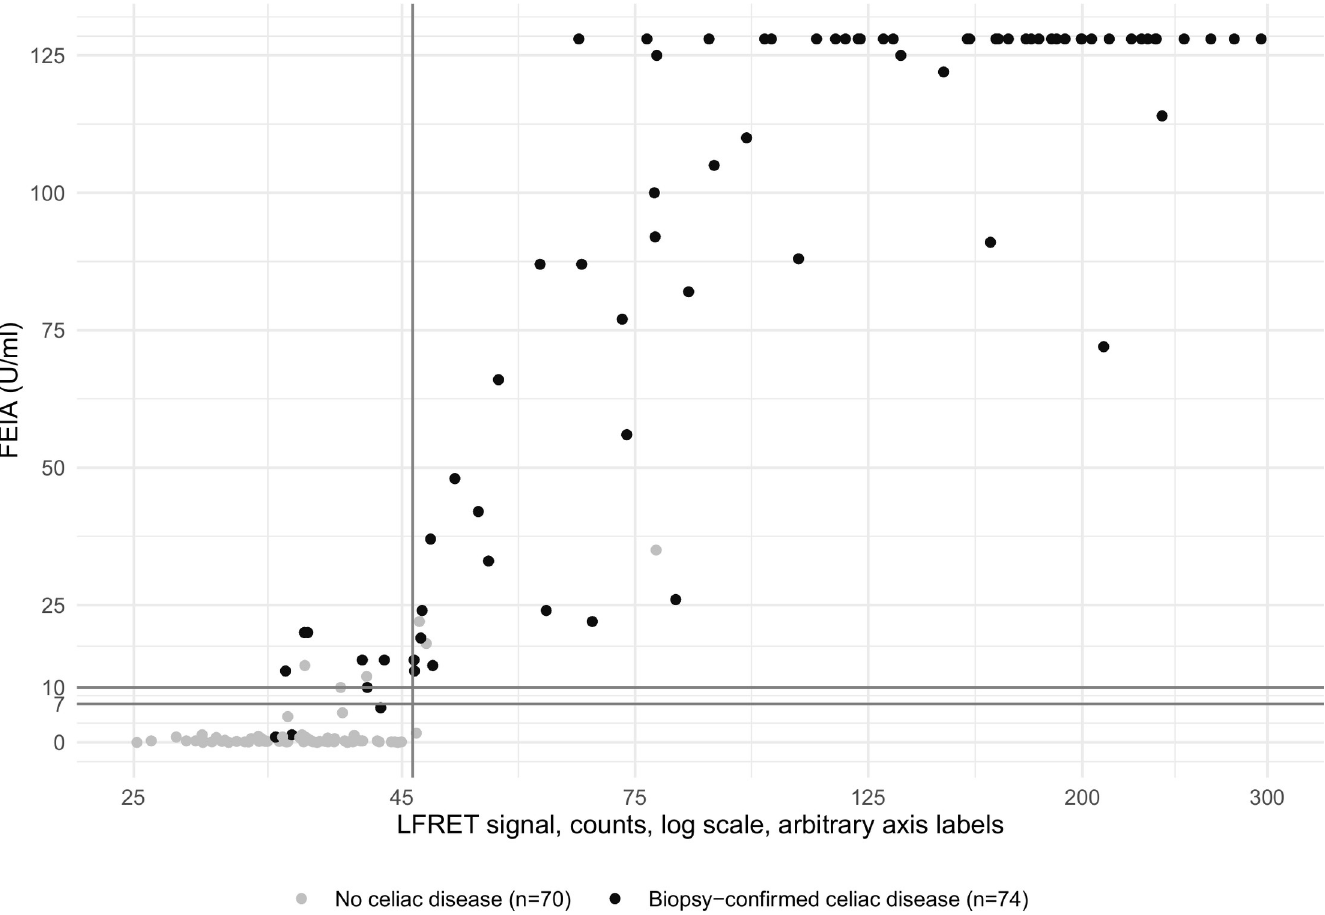
Fig 2. Anti-tTG-IgA FEIA results (x-axis) compared to LFRET results (y-axis) without IgG depletion. FEIA = fluorescent enzyme immunoassay. LFRET = protein L–based time-resolved Fo¨rster resonance energy transfer assay. FEIA result is expressed as U/ml. LFRET result is expressed as average of normalized acceptor wavelength emission counts from two replicates of the same sample, with two consecutive measurements from both replicates. Patients with biopsy-confirmed celiac disease (CD) are marked with a darker spot. The solid lines indicate cutoffs for FEIA and LFRET, with the area between 7 and 10 U/ml corresponding to an equivocal result for FEIA. FEIA cutoffs are set as determined by the manufacturer. LFRET cutoffs were determined by measuring the tTG-LFRET signals for 67 tTG-antibody negative samples (as defined by FEIA) and setting the LFRET cutoff at the mean LFRET signal plus two standard deviations (SD) (35.438 + 2 × 5.316 = 46.07 counts). Pearson correlation coefficient between FEIA and LFRET results is